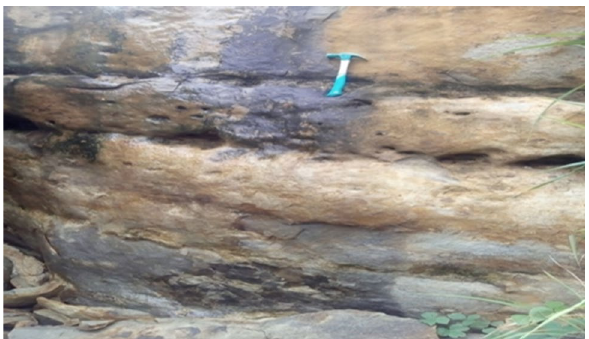
Fig. 14 Ebonyi River at high stage around Ekeberigwe–Egwudinagu